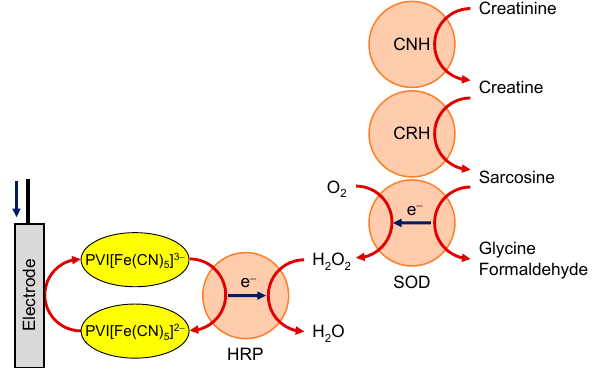
Figure 3. Schematic view of multi-enzymatic creatinine biosensor. CNH, CRH, SOD and PVI[Fe(CN) 5 ] 2 − /3 − indicate creatinine amidohydrolase, creatine amidohydrolase, sarcosine oxidase and pentacyanoferrate-bound poly(1-vinylimidazole), respectively.